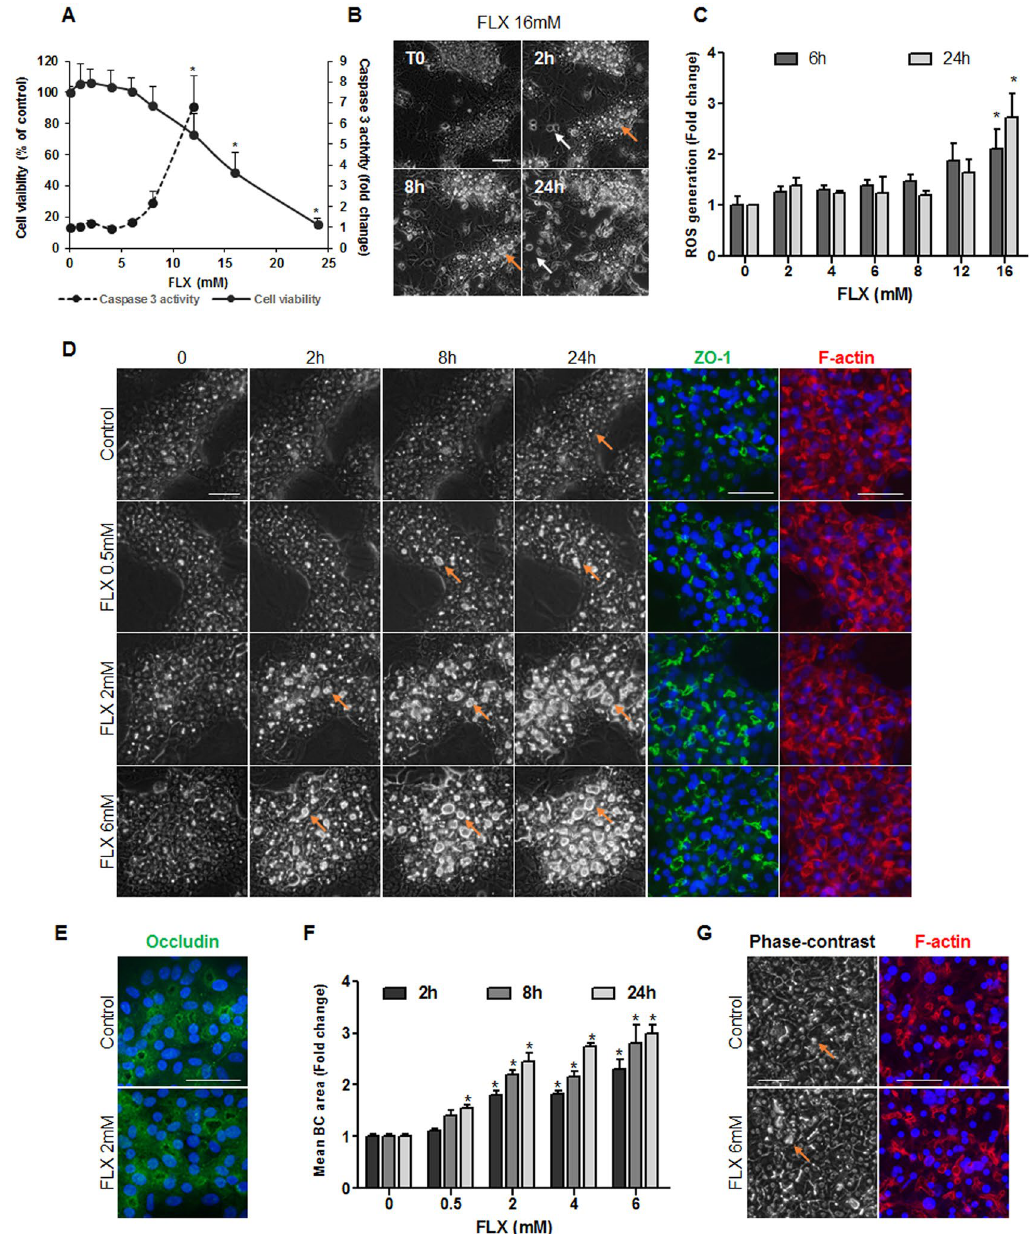
Figure 1. Cytotoxicity and alteration of BC structures by FLX in human HepaRG cells and primary hepatocytes. ( A ) HepaRG cells were incubated with different concentrations of FLX (0–24 mM) for 24 h. Cytotoxicity was measured using the MTT colorimetric and caspase-3 activity assays. ( B ) Representative phase-contrast images of 16 mM FLX-treated HepaRG cells showing higher sensitivity of primitive biliary-like cells (white arrows) than hepatocytes. ( C ) HepaRG cells were treated with different concentrations of FLX for 6 or 24 h. ROS generation was detected by the DCFDA specific substrate. ( D ) HepaRG cells were incubated with different non cytotoxic concentrations of FLX (0–6 mM) at different time points. Immunolabelling of the junctional ZO-1 protein (green) in HepaRG cells treated for 4 h with FLX compared with control cells. F-actin was localized using rhodamine-phalloidin fluoroprobe (red). ( E ) Immunolabelling of the junctional protein occludin (green) in HepaRG cells treated with 2 mM FLX compared with control cells. ( F ) Quantification of BC area after 2, 8 and 24 h using ImageJ 1.48 software as described in the Materials and Methods. Data were expressed as the fold change in the BC mean area relative to the mean area of untreated cells arbitrarily set at a value of 1. They represented the means ± SEM of 3 independent experiments. * p < 0.05 compared with that of untreated cells. ( G ) Phase-contrast images and F-actin localization (red) in PHH treated with 6 mM FLX for 2 h. Nuclei stained in blue (Hoechst dye). Phase-contrast images were captured using time lapse microscopy. Orange arrows indicate BC. The fluorescent images were obtained with a Cellomics ArrayScan VTI HCS Reader (bar = 50 µ